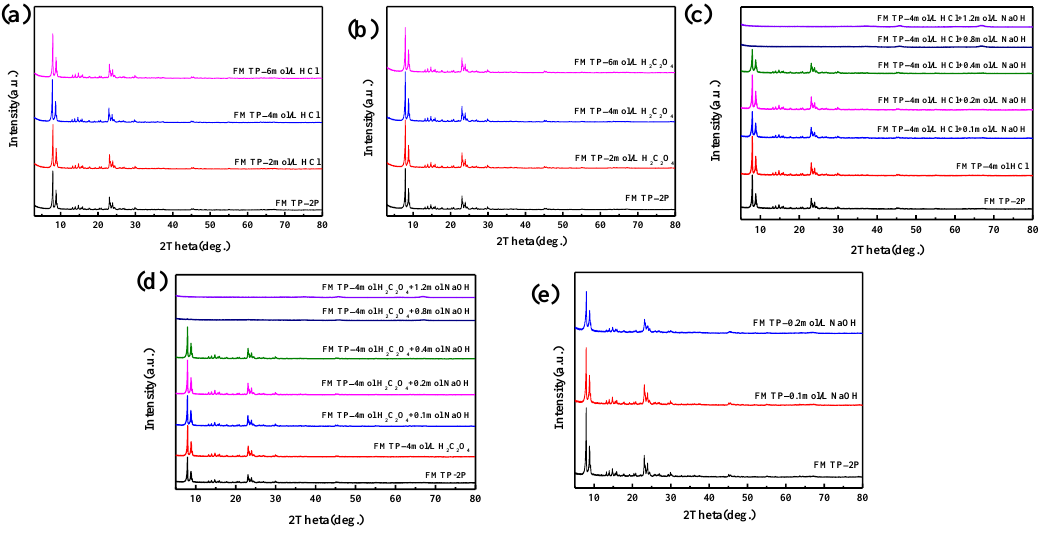
Figure 1. XRD spectra of spent catalyst samples after ( a ) HCl treatment; ( b ) H 2 C 2 O 4 treatment; ( c ) 4 mol/L HCl and alkali combined treatment; ( d ) 4 mol/L H 2 C 2 O 4 and alkali combined treatment; and ( e ) alkali treatment.